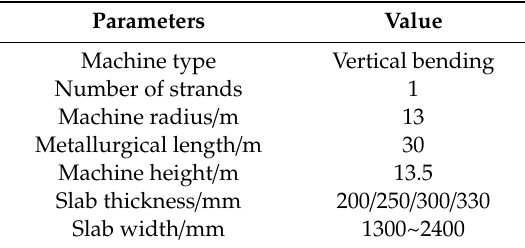
Table 1. Main parameters of caster.